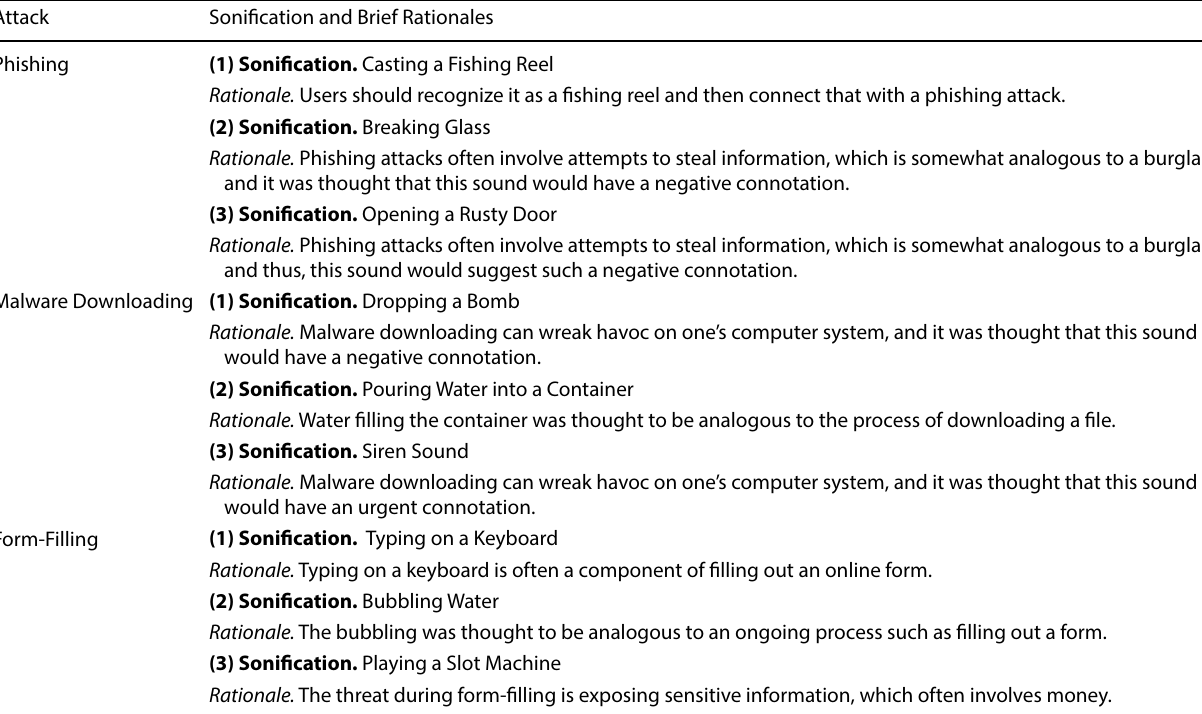
Table 1 The final set of sonifications and brief explanations for why those sounds were chosen Attack Sonification and Brief